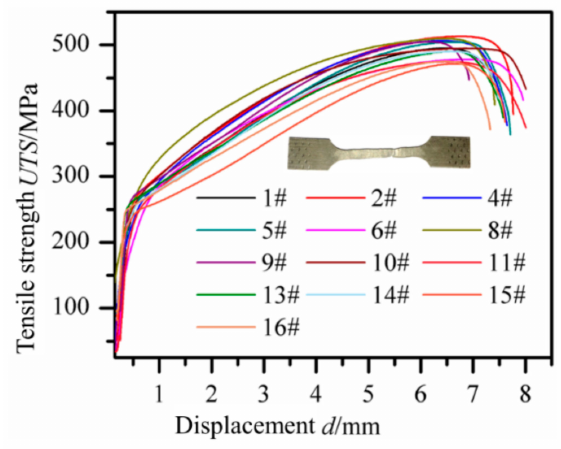
Figure 6. Tensile results of